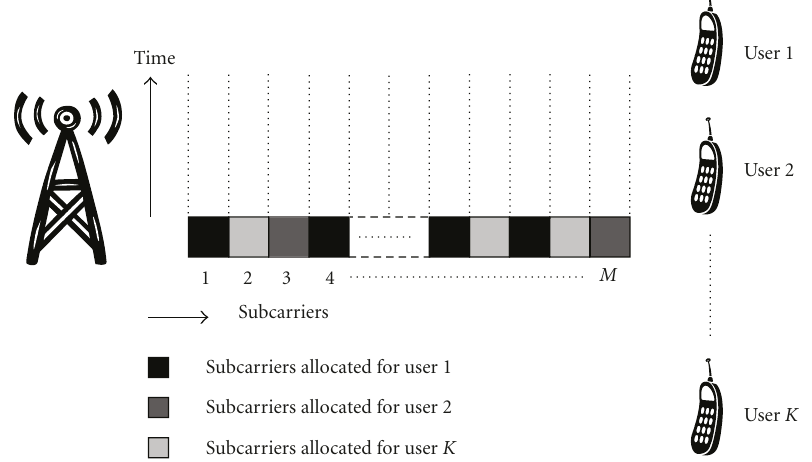
Figure 1: Downlink OFDMA system with K users and M